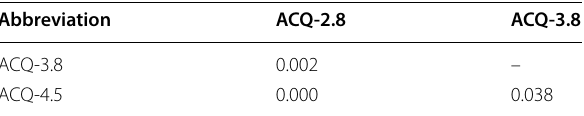
Table 5 Adjusted p value between each stake group treated with emulsified preservatives